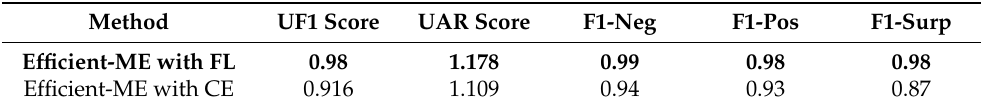
Table 6. Loss function evaluation for Efficient-ME pre-trained on balanced FER2013. Method UF1 Score UAR Score F1-Neg F1-Pos F1-Surp Efficient-ME with FL 0.98